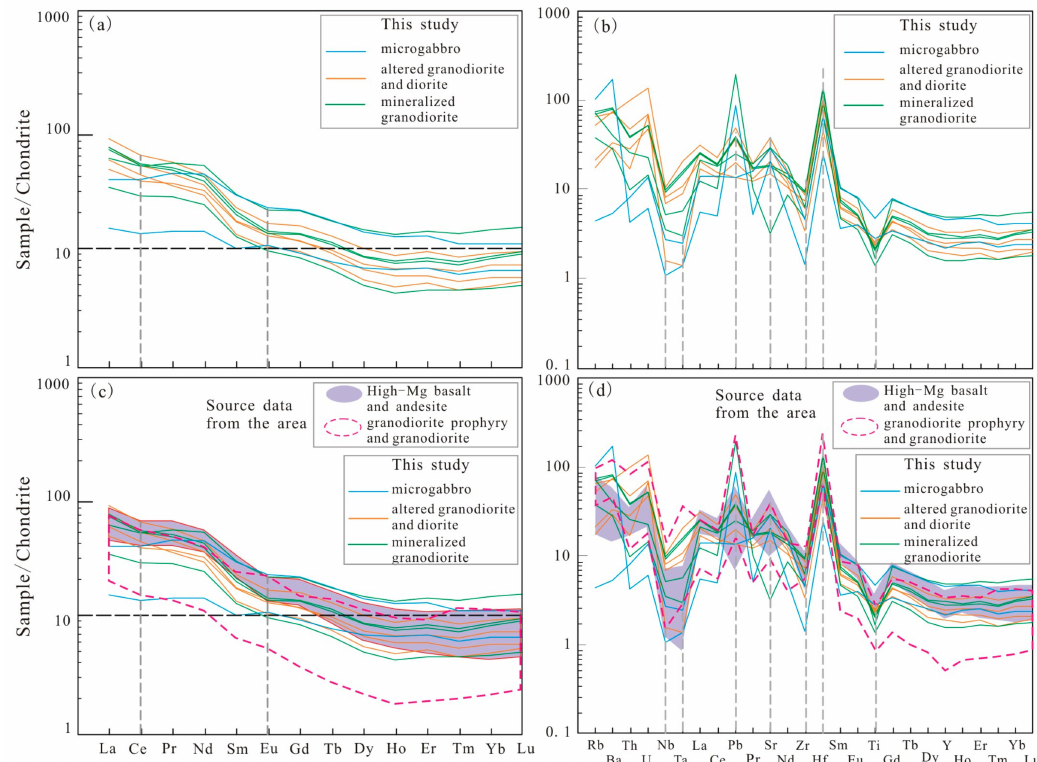
Figure 5. ( a ) Chondrite-normalized REE patterns and ( b ) primitive mantle-normalized trace element patterns for the early Paleozoic igneous rocks in the DBS-TS porphyry Cu-Mo deposit. ( c ) REE and ( d ) trace element patterns for igneous rocks in the DBS-TS porphyry Cu-Mo deposit in comparison with high Mg volcanic rocks and unaltered granodioritic rocks in the area. Note that the values of chondrite and primitive mantle are from [69], the data of high-Mg basalt and andesite are from [26], and the data of granodiorite porphyry and granodiorite are from [13,24,28].